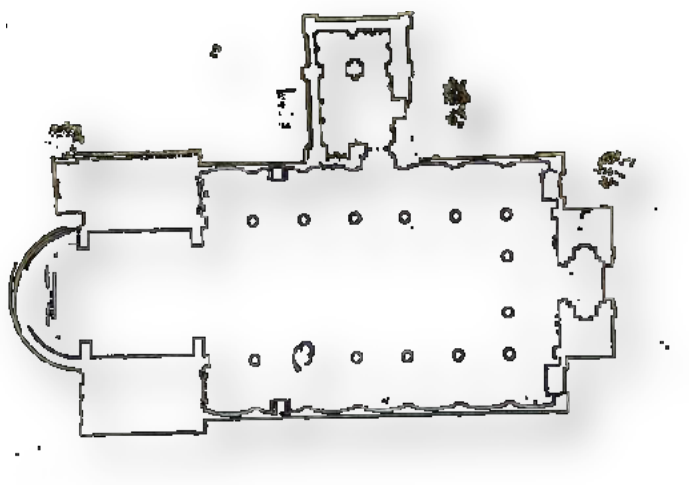
Fig. 5: Footprint of the church and bell tower as part of the ancient